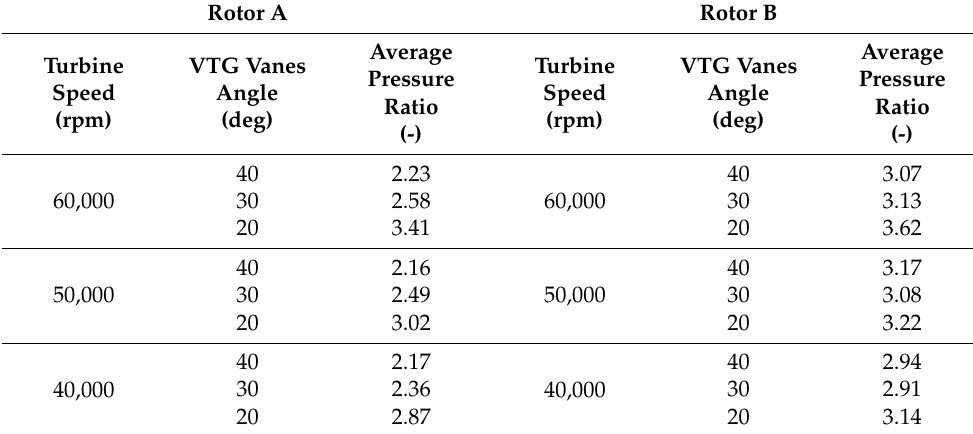
Table 10. The average PR of the second-stage rotor for two rotor geometries, three different turbine speeds and VTG